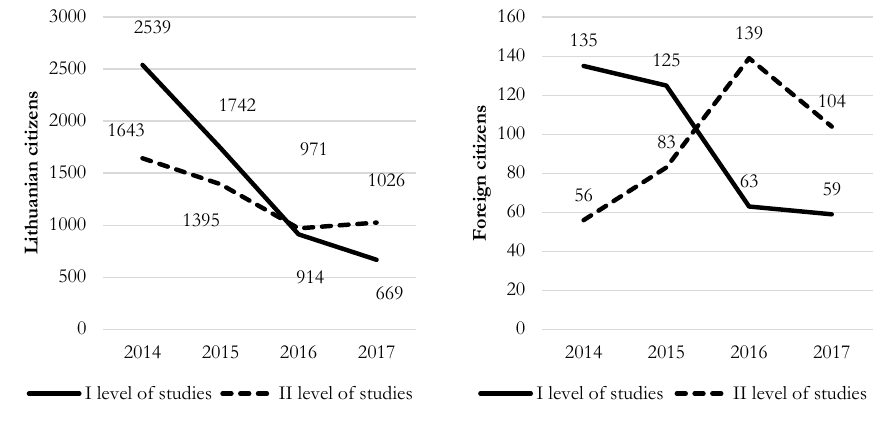
Fig. 8 – Dynamics of the number of students admitted to study at MRU (1st and 2nd cycle). Source: Mykolas Romeris University (2019)